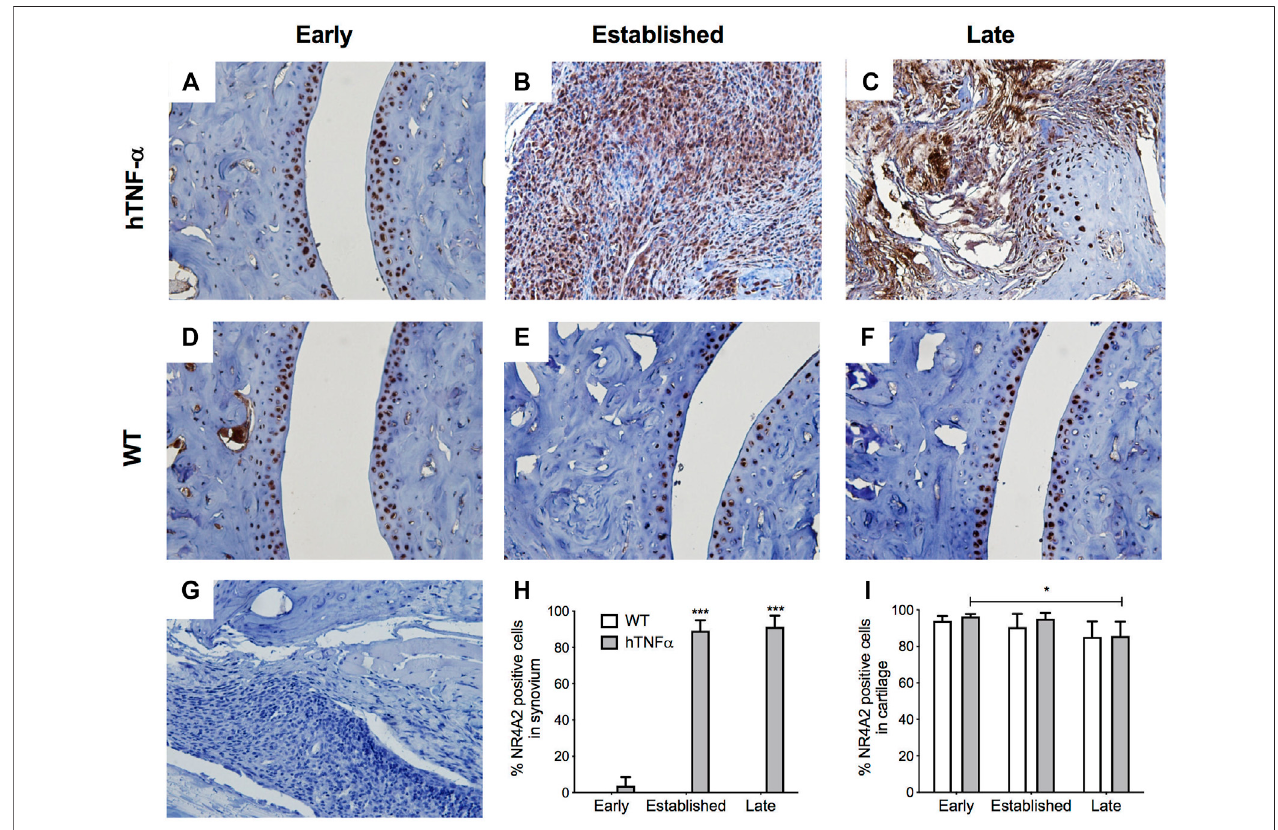
FIGURE4| Localization ofNR4A2incartilageandsynovium.NR4A2protein wasdetected inpawsofwild-type andhTNF- α mice atearly (A,D) ,established (B,E) , andlate (C,F) stagesofdiseasebyimmunohistochemistry.Isotypecontrolwasappliedtoatransgenicsectionfromthelatestageofdisease (G) .Representativeimages at 400× magni fi cation are shown. Scoring of NR4A2 positive cells in synovium (H) and cartilage (I) . Unpaired t -test, * p < 0.05, *** p < 0.0005.